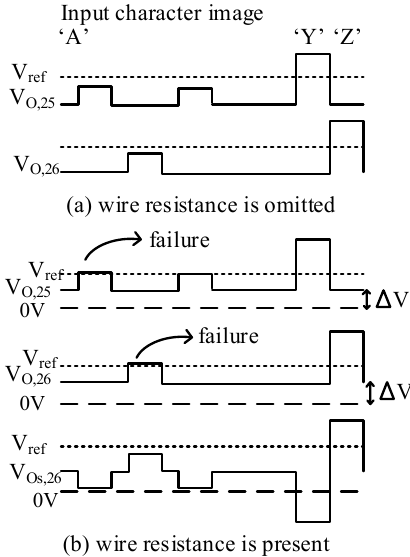
Figure 4. The concept of the proposed circuit for compensating the output voltage variation caused by wire resistance. ( a ) The ideal output of the 25th and 26th columns, which are trained to recognize character images of “Y” and “Z”, respectively. ( b ) The output voltage of the 25th and 26th columns when the wire resistance is taken into account. V Os,26 is the output of subtractor for the 26th column, as depicted in Figure 3 .